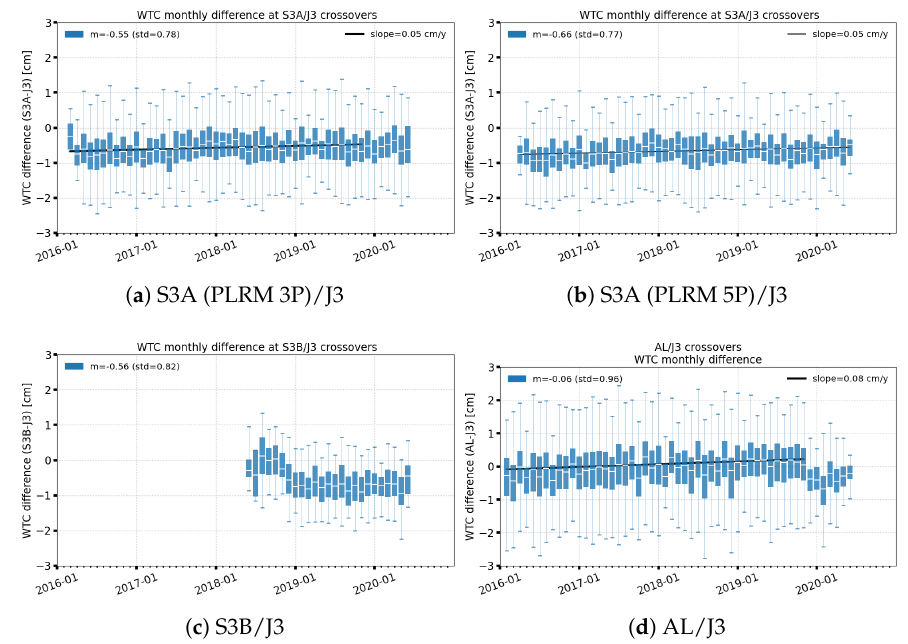
Figure 14. Monthly average of WTC differences at crossover points with Jason-3 for ( a ), ( b ) S3A, S3B ( c ) and AltiKa ( d ) missions.